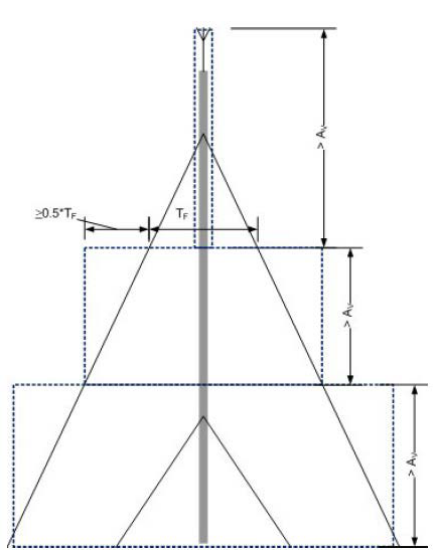
Figure 3 . Vertical segmentation of antenna based on footprint and vertical accuracy (Eurocontrol TOD Manual, page 197,